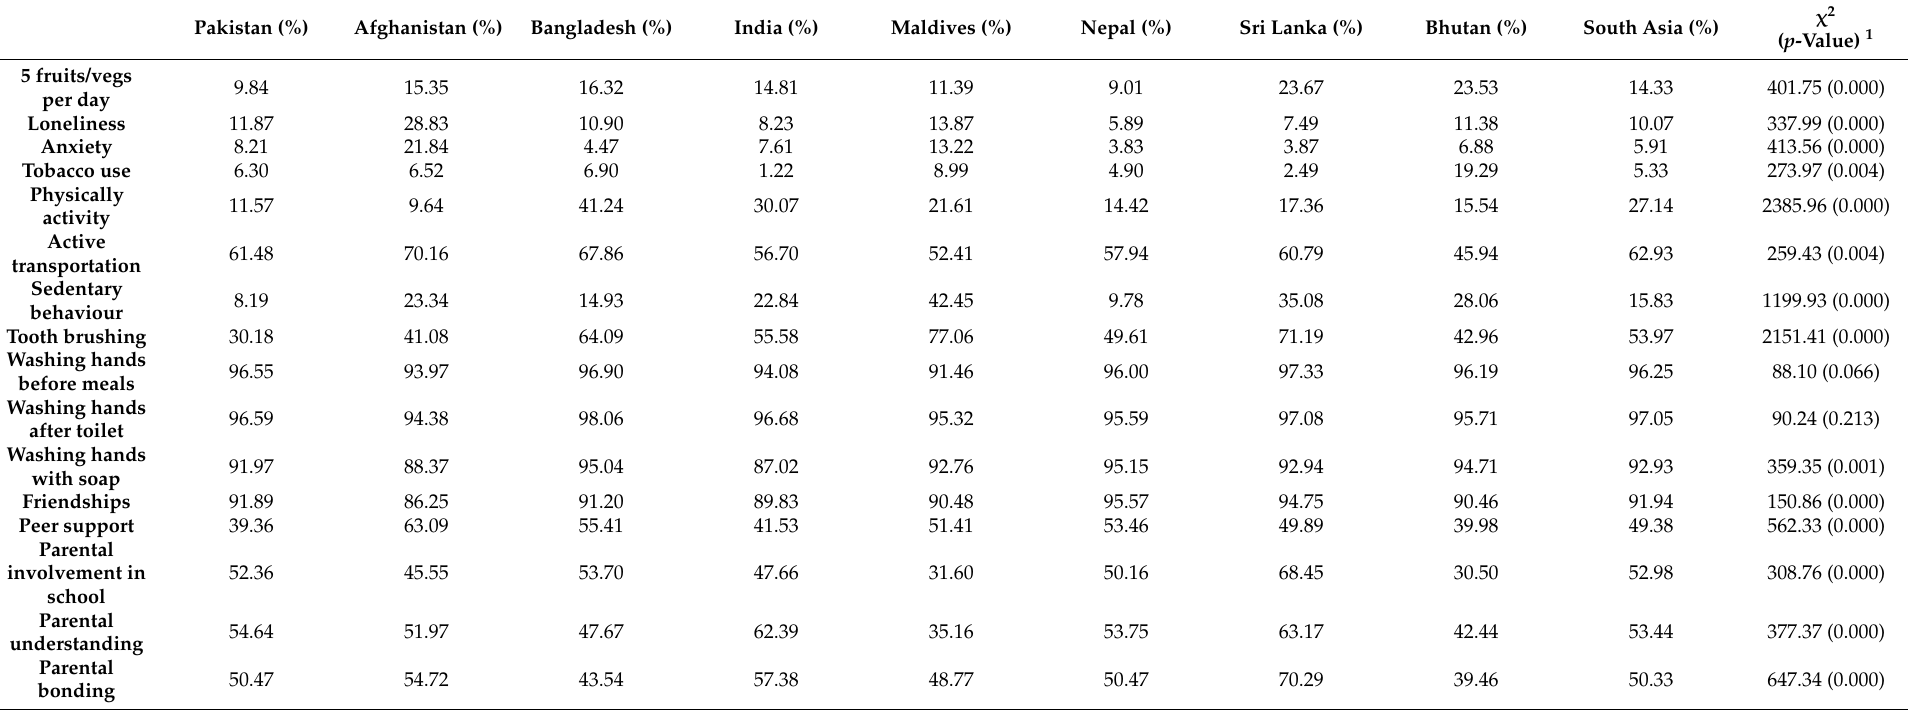
Table 5. Stratified prevalence of health behaviours among South Asian schooled adolescents aged 12–15 years, Global School-Based Student Health Survey